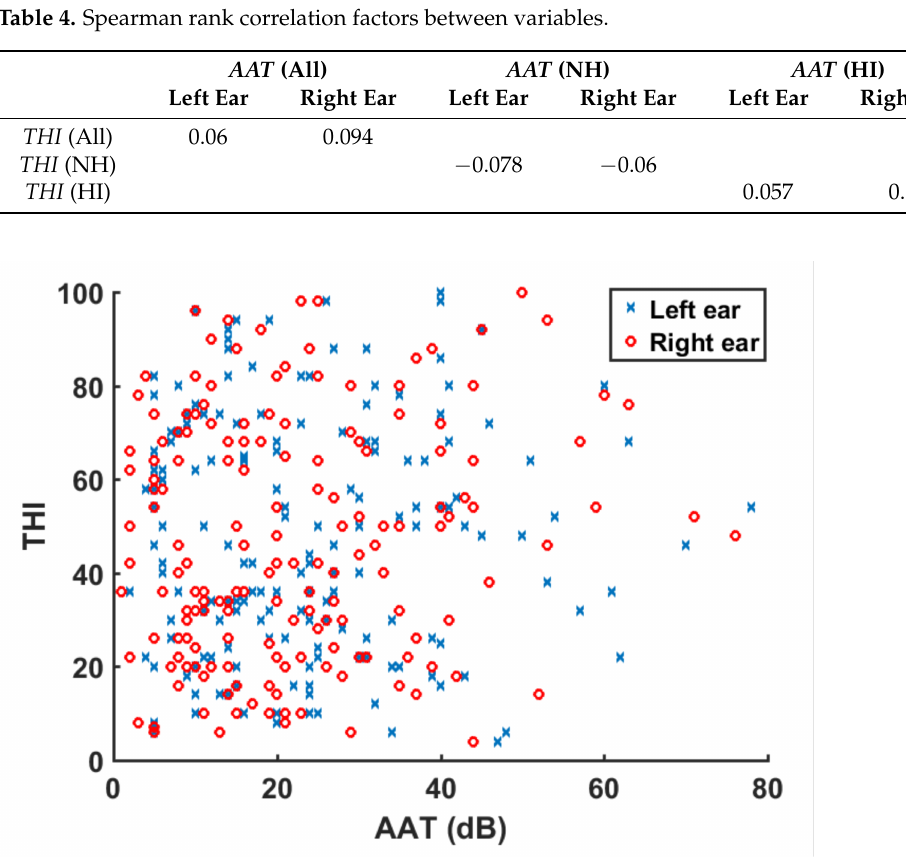
Figure 4. Scatter plot of AAT versus THI for the tinnitus